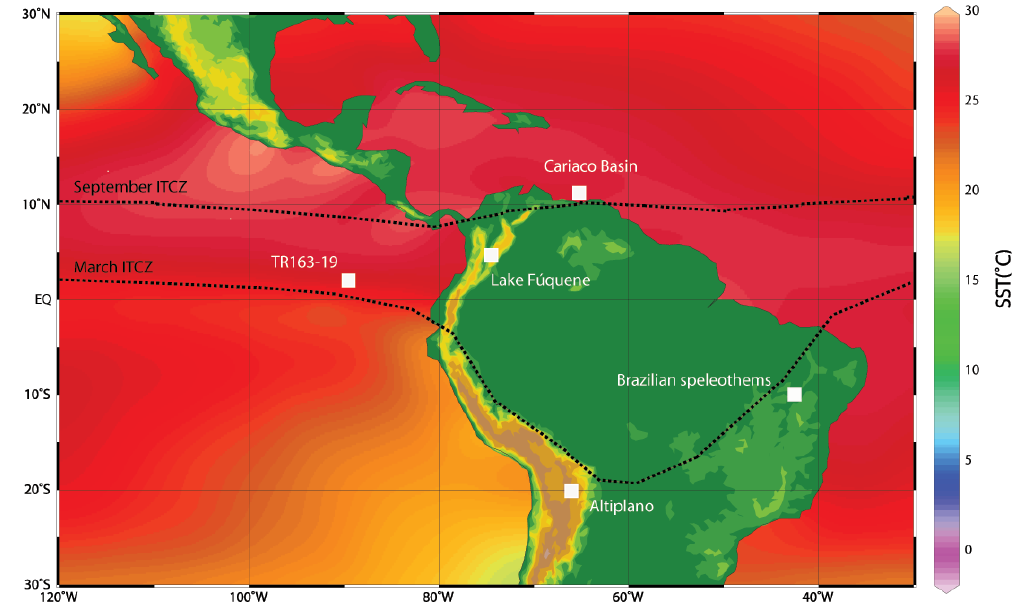
Fig. 1. Current annual mean sea surface temperature (SST) (Locarnini et al., 2006) and generalized position of the inter tropical convergence zone (ITCZ) during March and September. Location of sites: Lake F´uquene (5 ◦ 28 0 N, 73 ◦ 45 0 W; 2540ma.s.l. – above sea-level, Colombia), TR163-19 (2 ◦ 15.5 0 N, 90 ◦ 57.1 0 W; 2348m water depth, equatorial Pacific) (Lea et al., 2000), MD03-2622 (10 ◦ 42.69 0 N, 65 ◦ 10.15 0 W; 877m water depth, Cariaco Basin) (Gonz´alez et al., 2008), Brazilian speleothem (10 ◦ 10 0 S, 40 ◦ 50 0 W; 500ma.s.l.) (Wang et al., 2004), and Bolivian Altiplano (20 ◦ 14.97 0 S, 67 ◦ 30.03 0 W; 3653ma.s.l.) (Baker et al., 2001). Colours on land represent elevation above